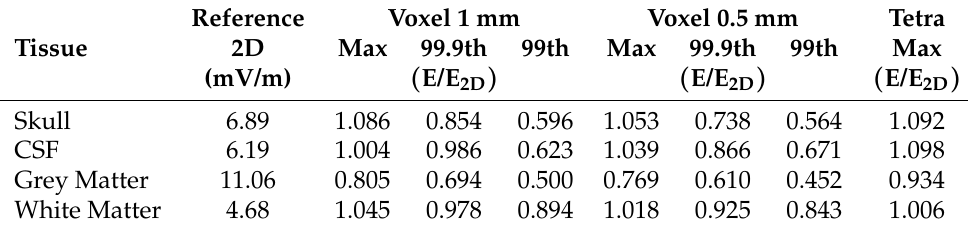
Table 4. Deviation of the E -field in the planar